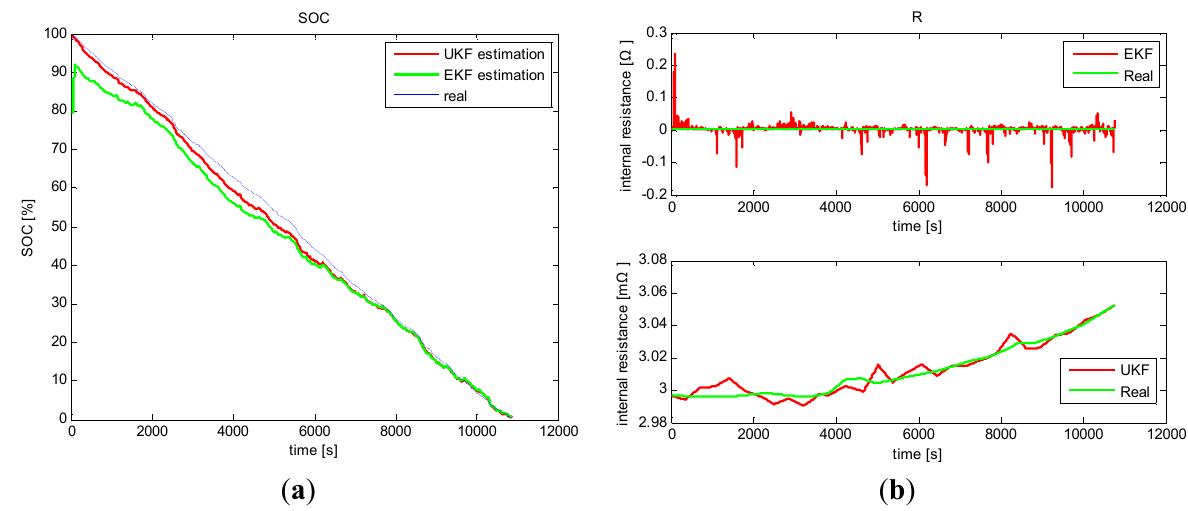
Figure 6. Joint estimation of the SOC and internal resistance. ( a ) Jointly estimated SOC; ( b ) Jointly estimated internal